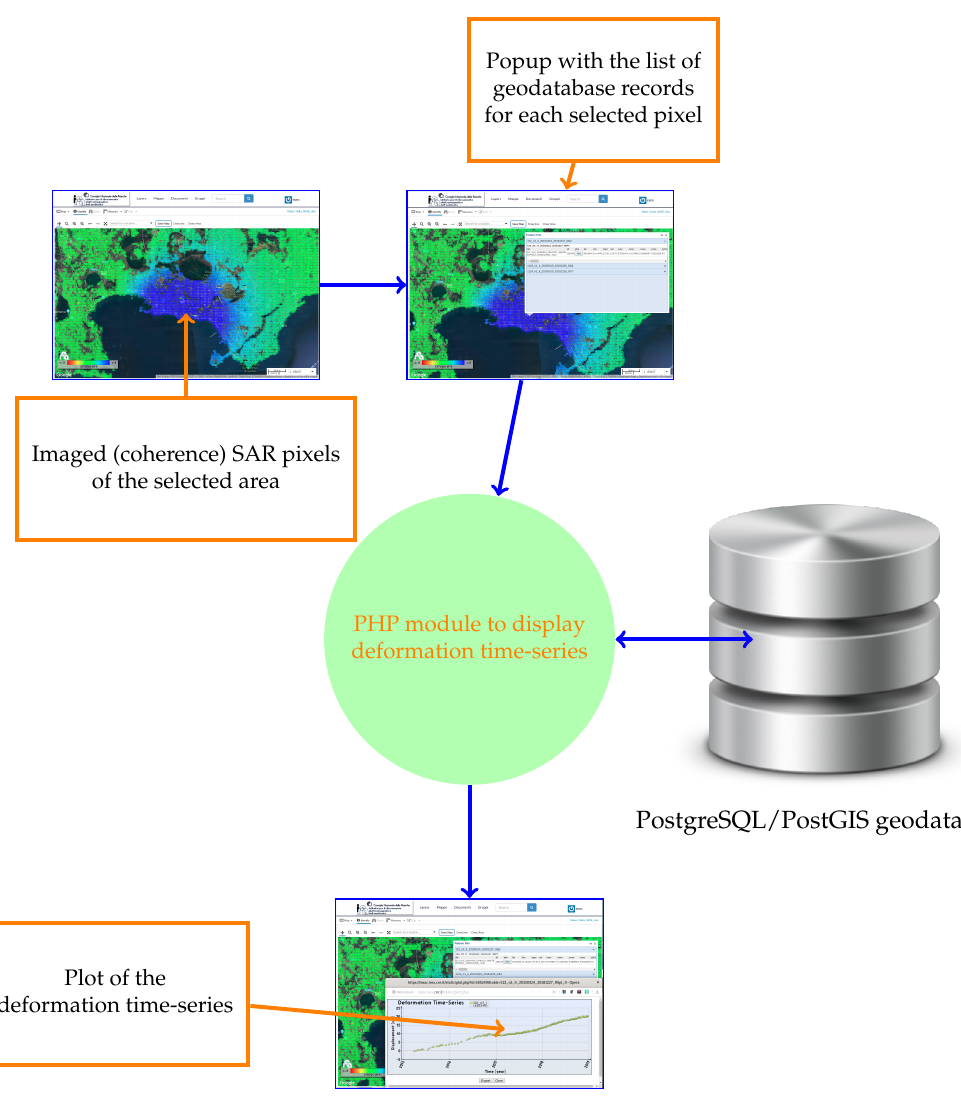
Figure 9. Flow chart of the deformation time-series plotting